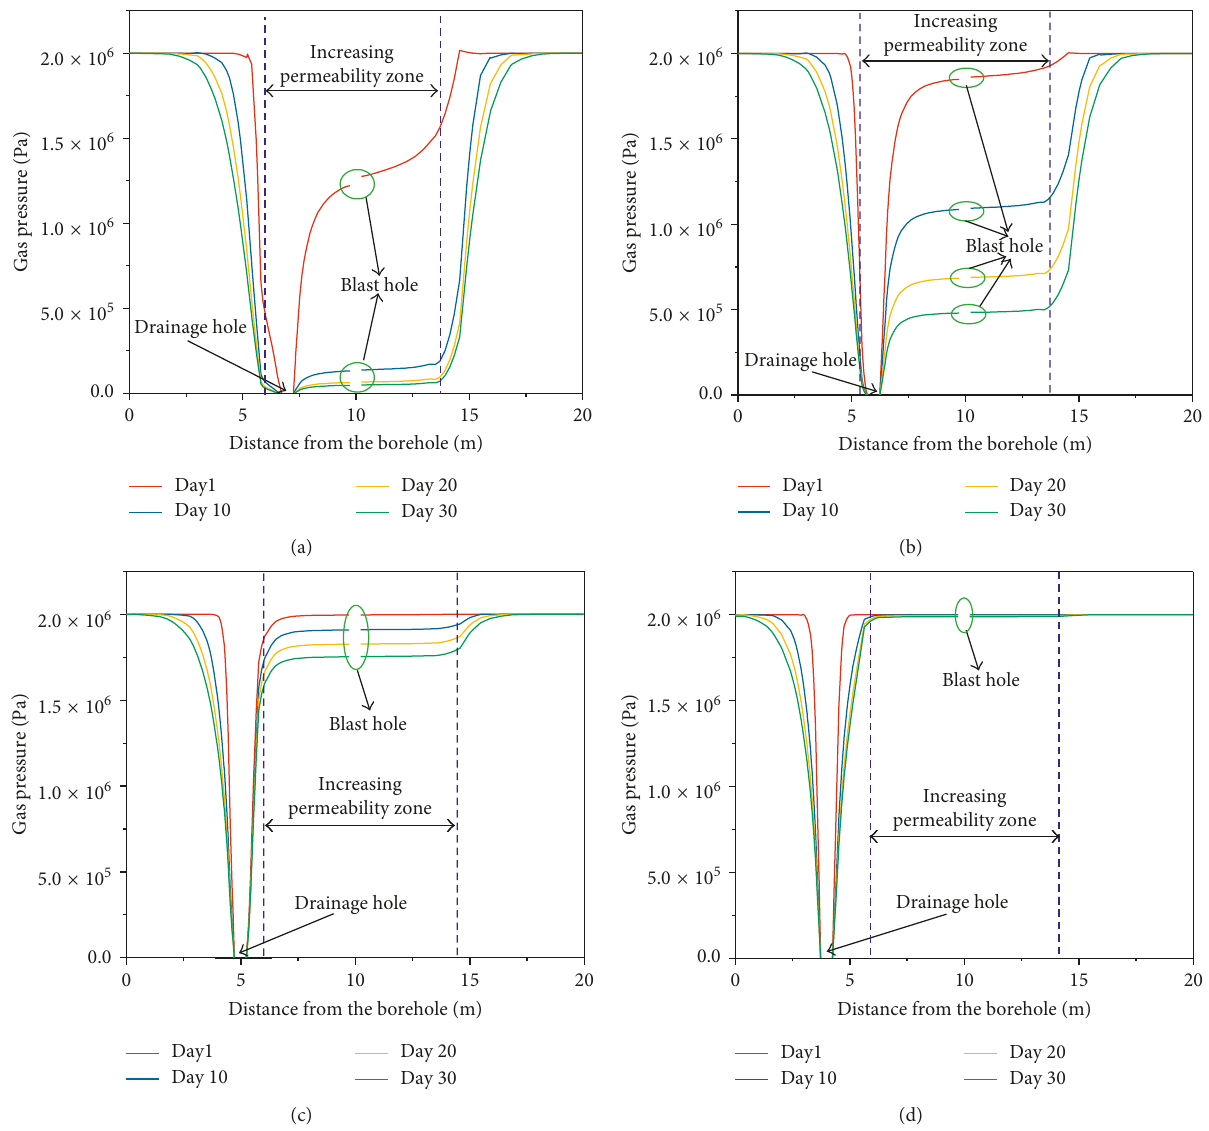
Figure 14: Variations of gas pressure as a function of time: (a) borehole spacing between the drainage hole and the blast hole is 3m; (b) borehole spacing is 4m; (c) borehole spacing is 5 m; (d) borehole spacing is